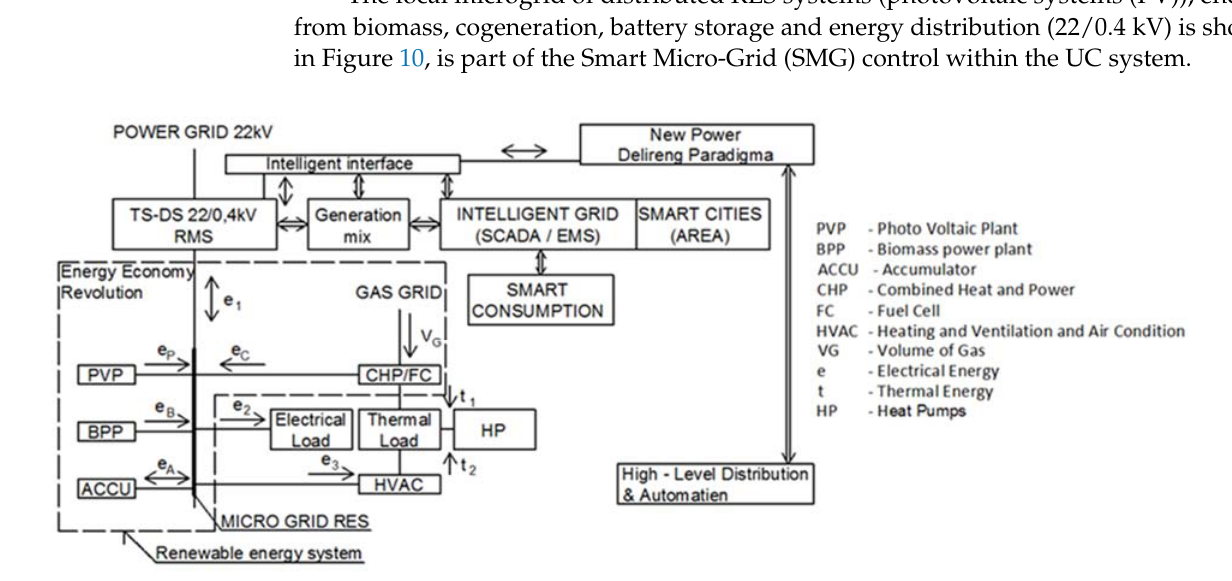
Table 1. Reference values for EPB with NZEB for different climate zones in the EU.